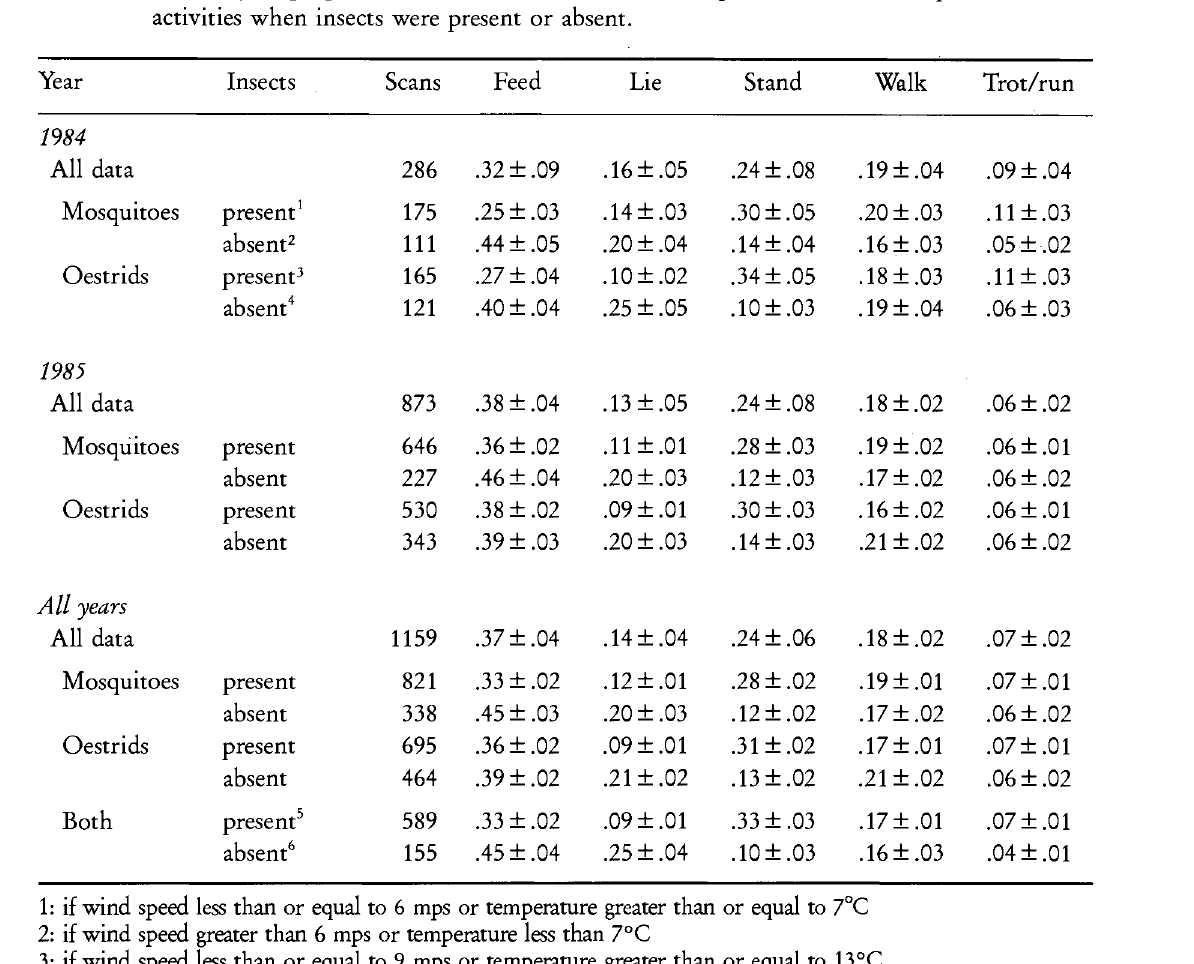
Table 4.5. Summary of proportion of time in summer the Porcupine Caribou Herd spent in various activities when insects were present or